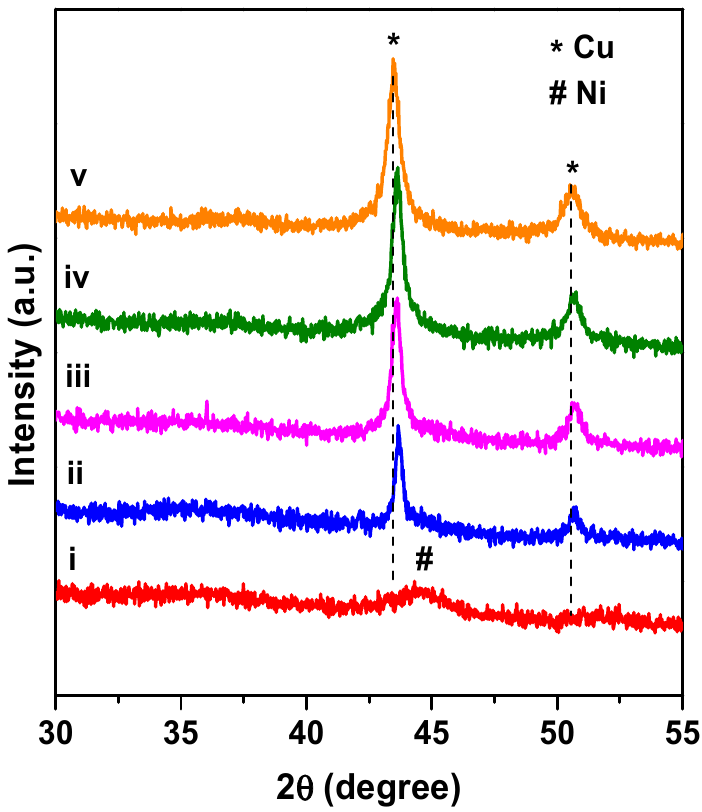
Figure 1. XRD patterns of reduced catalysts ( i ) Ni 20 /m − SiO 2 , ( ii ) Ni 15 Cu 5 /m − SiO 2 , ( iii ) Ni 10 Cu 10 /m − SiO 2 , ( iv ) Ni 5 Cu 15 /m − SiO 2 , and ( v ) Cu 20 /m − SiO 2 (total metal loading fixed at 20 wt.% with varied relative Ni and Cu loading).